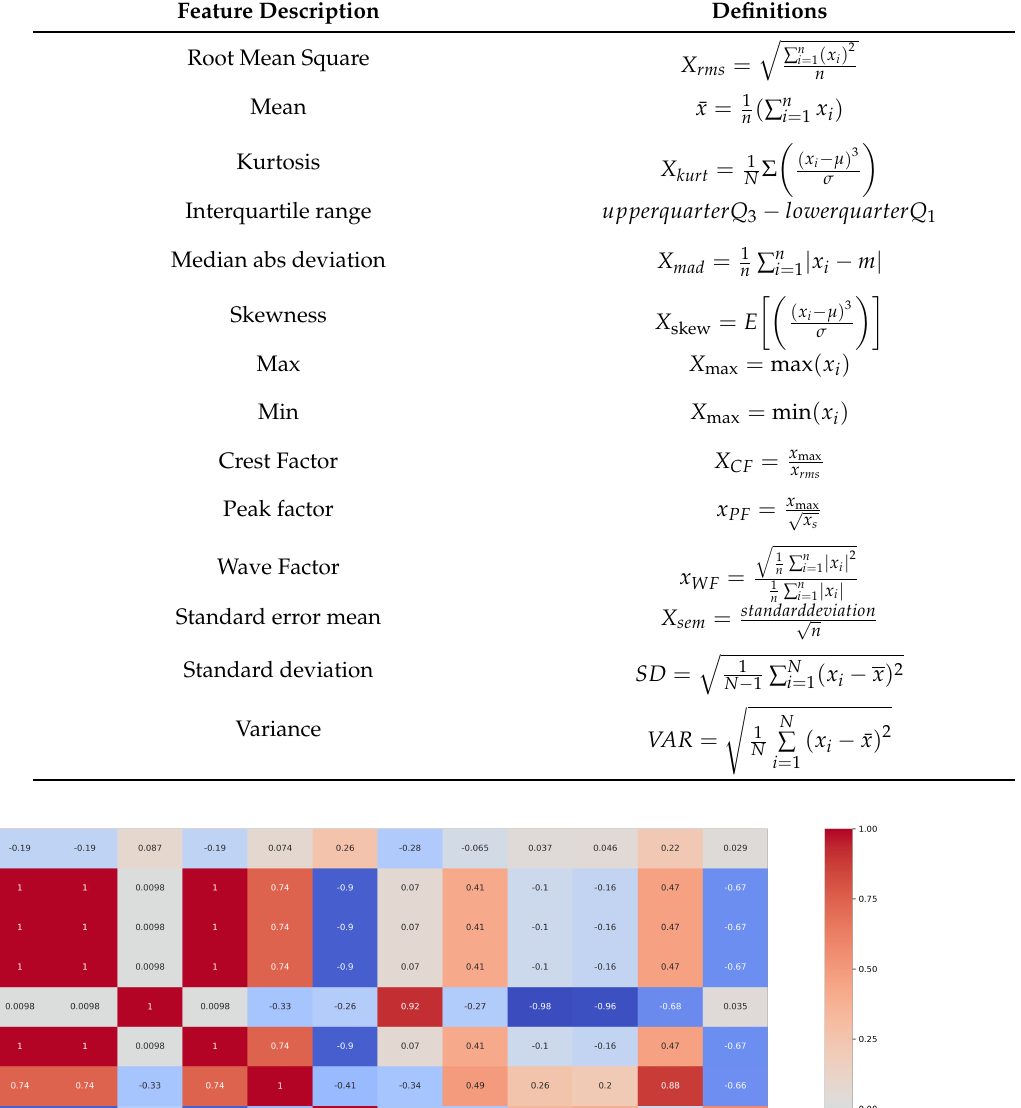
Table 4. The Definitions of the Statistical Features Extracted.